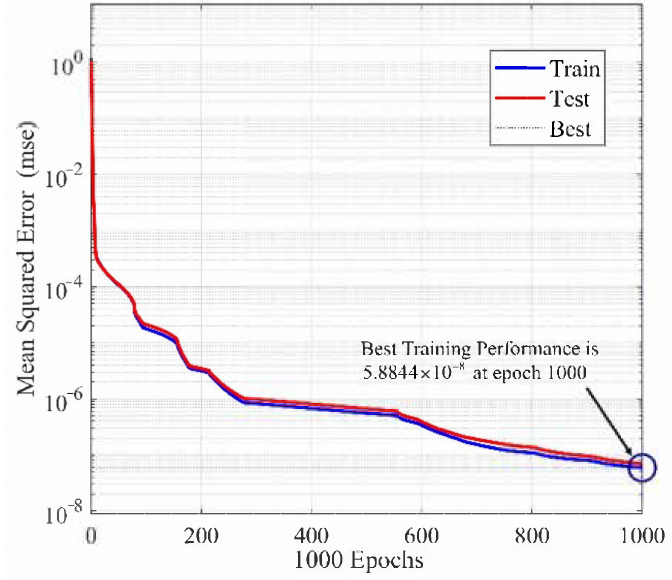
Figure 10. Relation between the MSE and the training